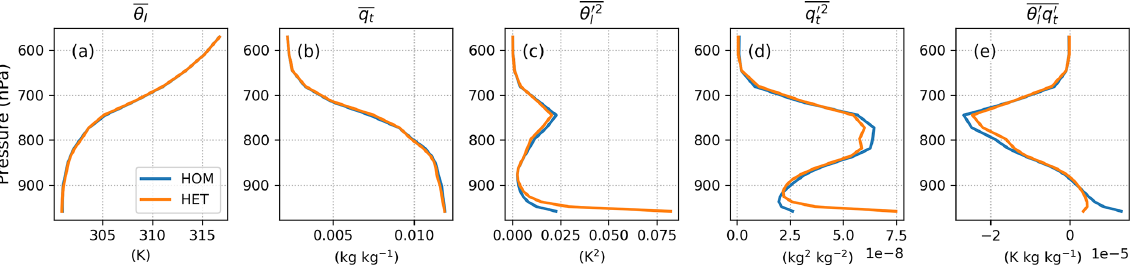
Figure 10. Same as Fig. 6, except for non-precipitating cloudy days. Note that the y axis here spans higher than Fig.